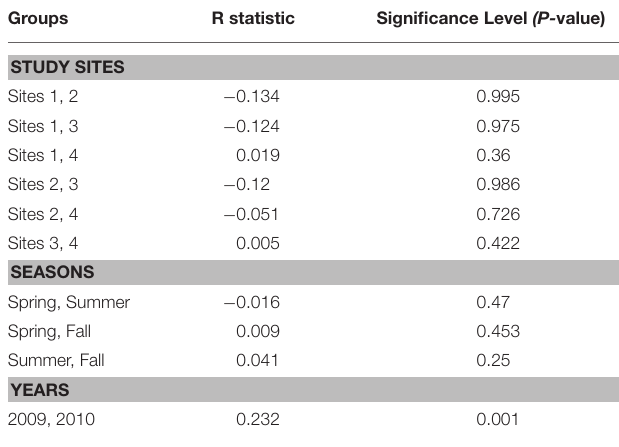
TABLE 2 | Pairwise tests for differences in water quality between the study sites, seasons, and years.